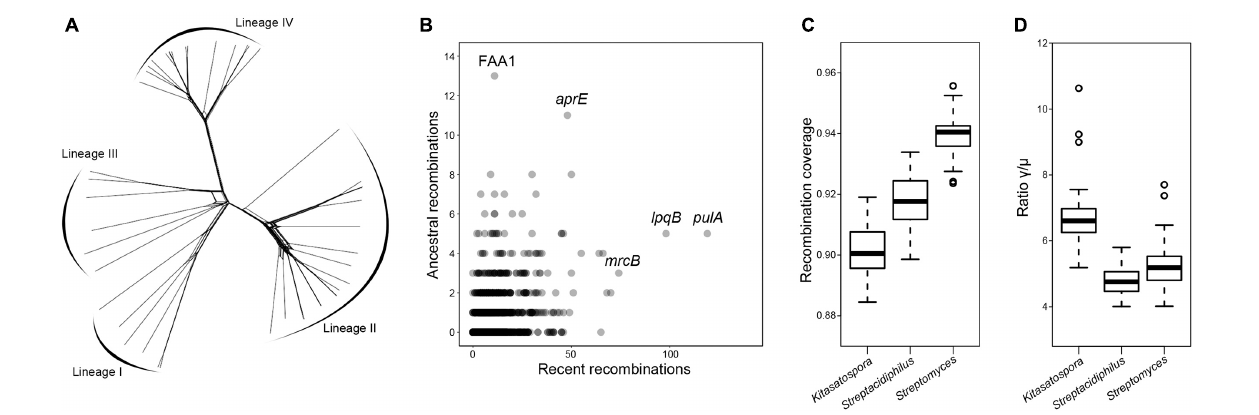
FIGURE 7 | Extensive recombination in Kitasatospora . (A) Phylogenetic network inferred with the concatenation of single-copy core genes. Lines between splits show where recombination has occurred. (B) Core genes that have undergone recent and ancestral recombination. Horizontal and vertical axes show the estimated number of recent and ancestral recombinations, respectively. Names of some of the most frequently recombined genes are shown. (C,D) Comparison of the recombination coverage and the ratio γ / µ between genera, respectively. These two parameters were calculated from 50 subsets each containing 50 different species (pairwise ANI < 95%; 20 for genus Kitasatospora , 20 for genus Streptomyces , and 10 for genus Streptacidiphilus ) randomly selected from the genome dataset. The boxplot shows the median, and the first and third quartiles as the lower and upper hinges. Outliers are indicated as dots. All values are significantly positive ( p < 0.001, paired two-tailed Student’s t